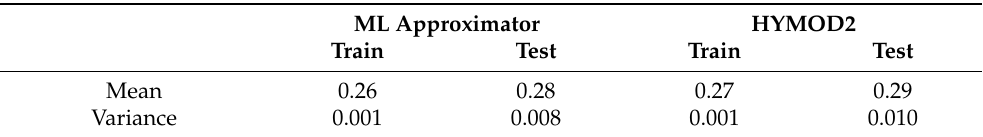
Table 5. Mean value and variance of the ML approximator loss function and HYMOD2 performance metric in the Nyangores River case study.